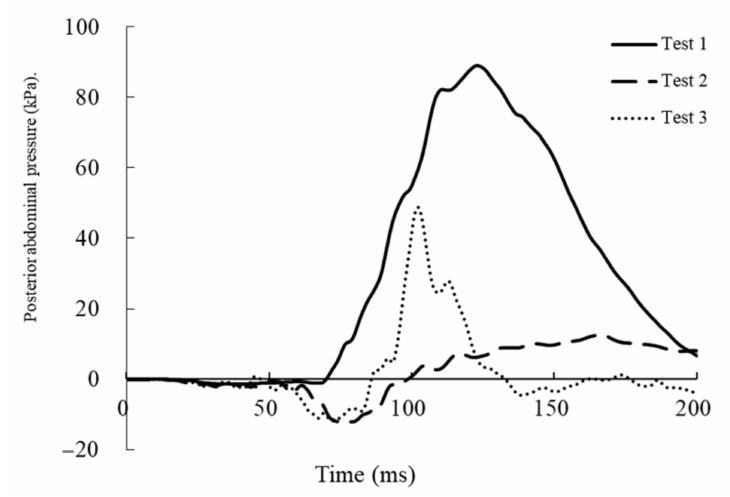
Figure 7. Time course of posterior abdominal pressure in each test. Table 1. Maximum values of the neck injury criteria, chest deflections, and abdominal pressures under each